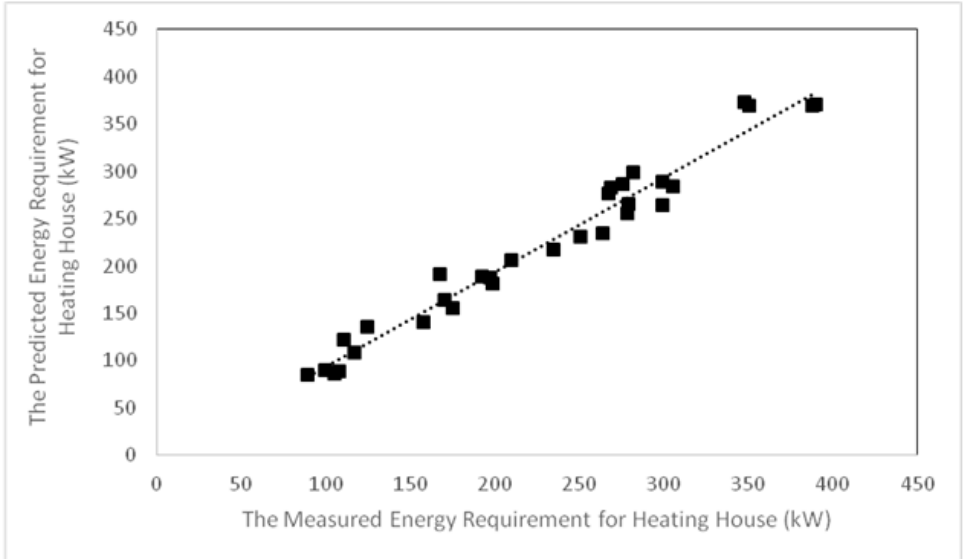
Figure 15. Comparison between predicted and measured energy requirement for heating the house during winter